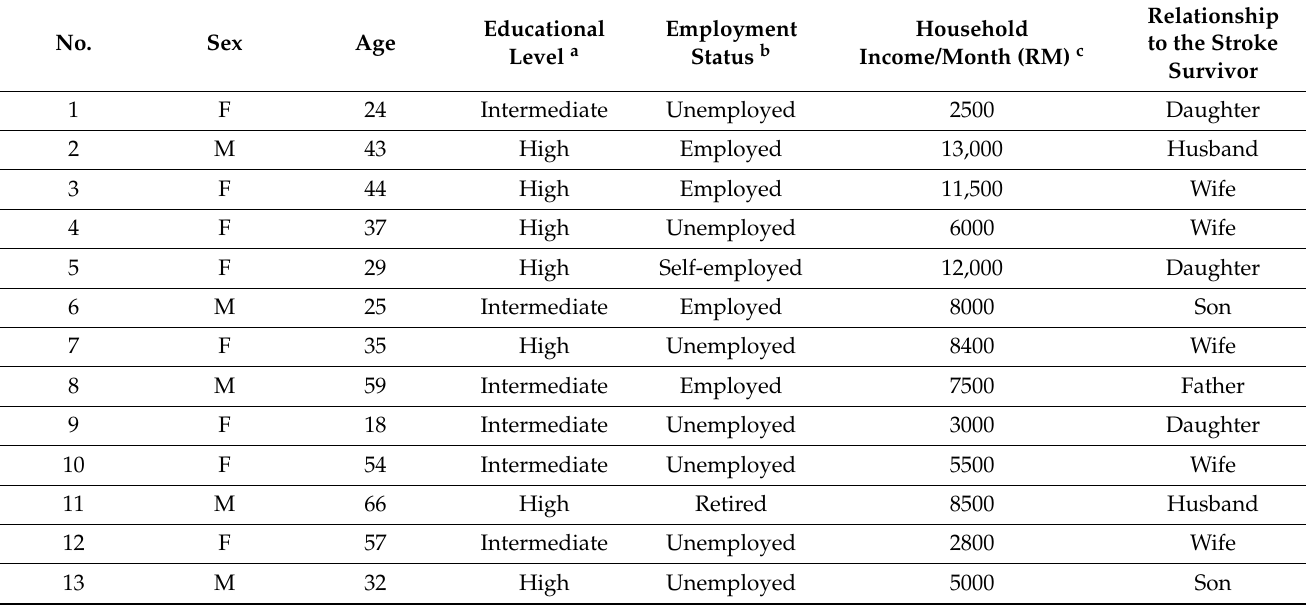
Table 1. Characteristics of informal caregivers and relationship to the stroke survivor.